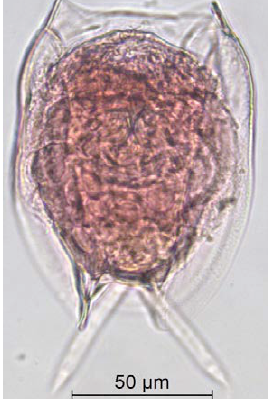
Image 1. Brachionus kostei Shiel (lateral view)